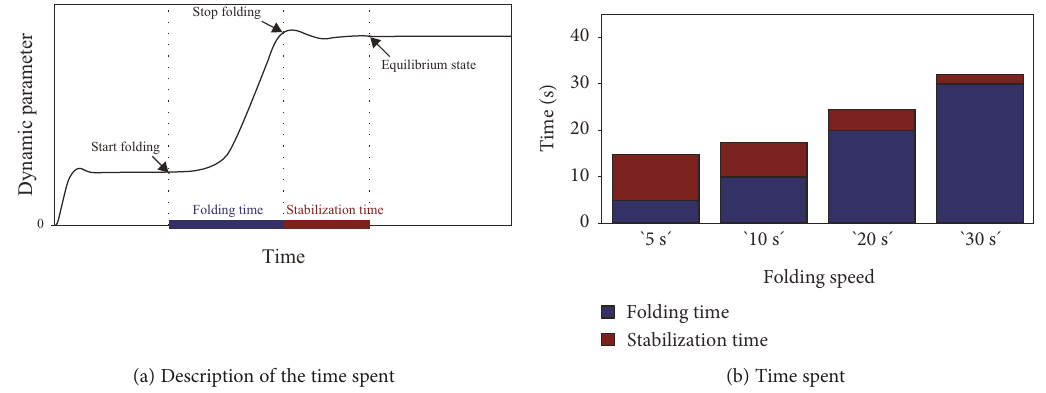
Figure 9: Time spent at di ff erent folding speeds.